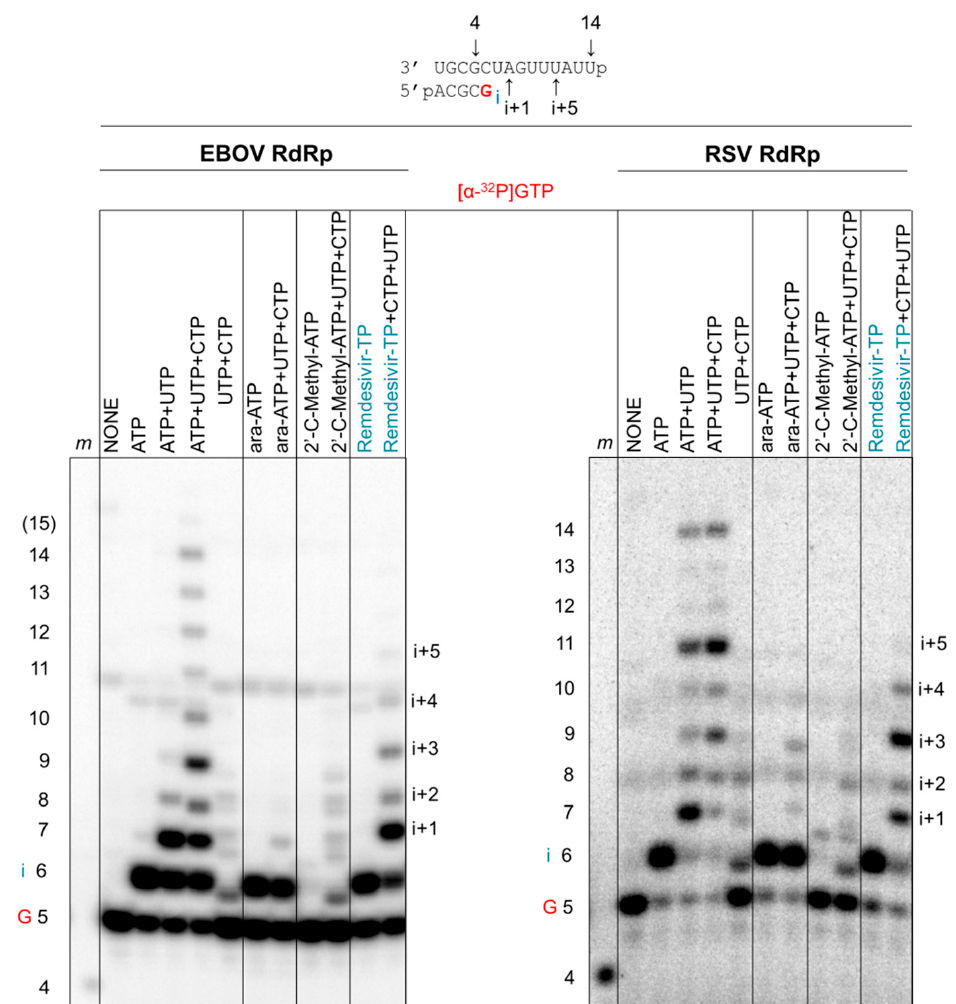
Figure 7. Inhibition of RNA synthesis with different nucleotide analogue inhibitors. RNA synthesis was monitored with EBOV RdRp and RSV RdRp in the presence of [ α - 32 P]-GTP and various combinations of